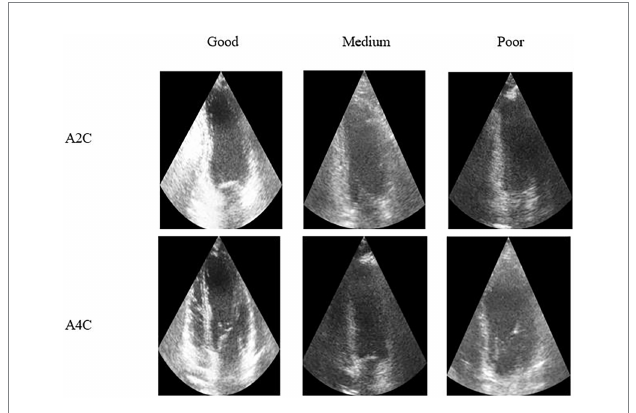
FIGURE 2 Representative echocardiography images, across two different cardiac views, from good to poor quality ultrasound [images from (12)].